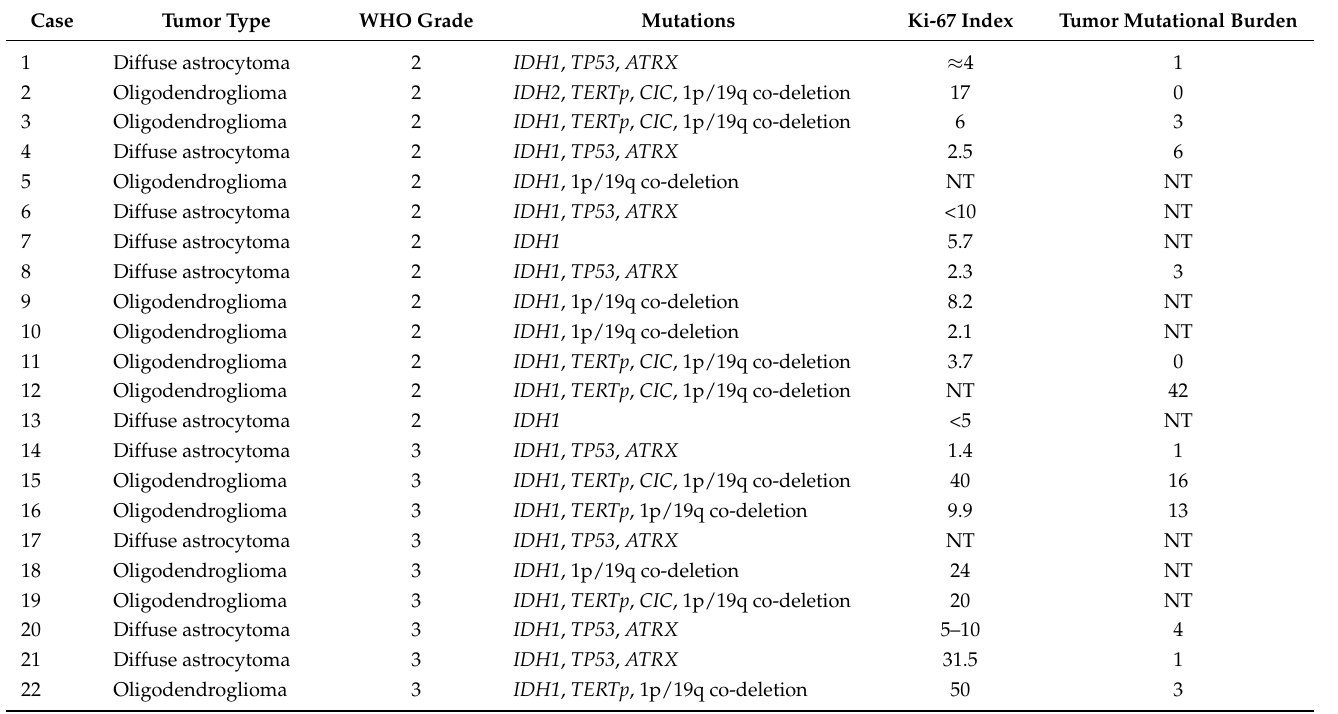
Table 2. Histopathologic